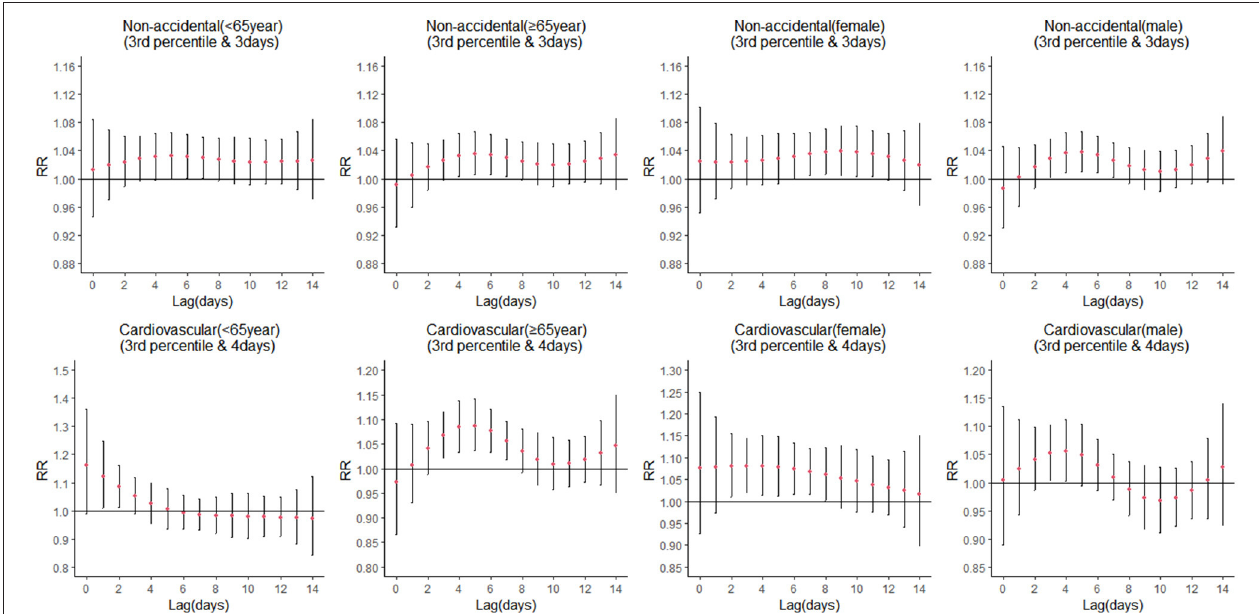
FIGURE 2 | Lag-effects of the cold spell on mortality (non-accidental and cardiovascular) stratified by sex and age.